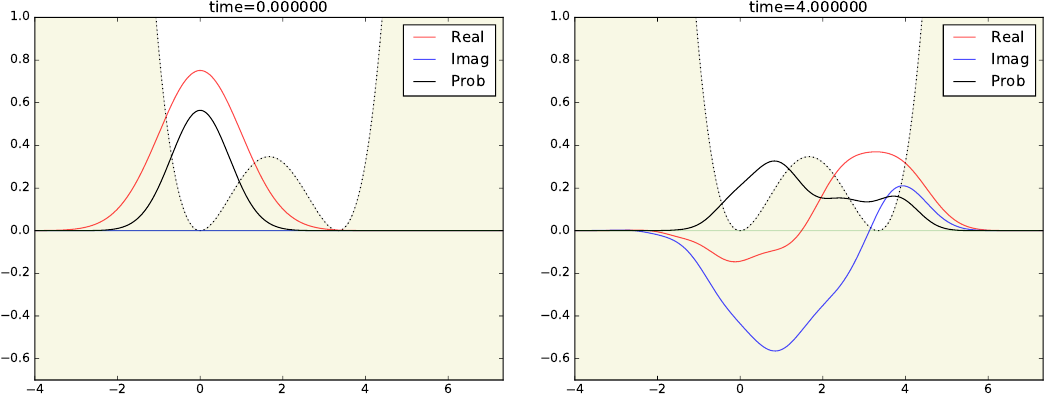
Figure 3 . Plots of the real and imaginary parts of (cid:9) and the probability (cid:9)(cid:9) (cid:3) at times mt = 0 ; 4 for g = 0 :